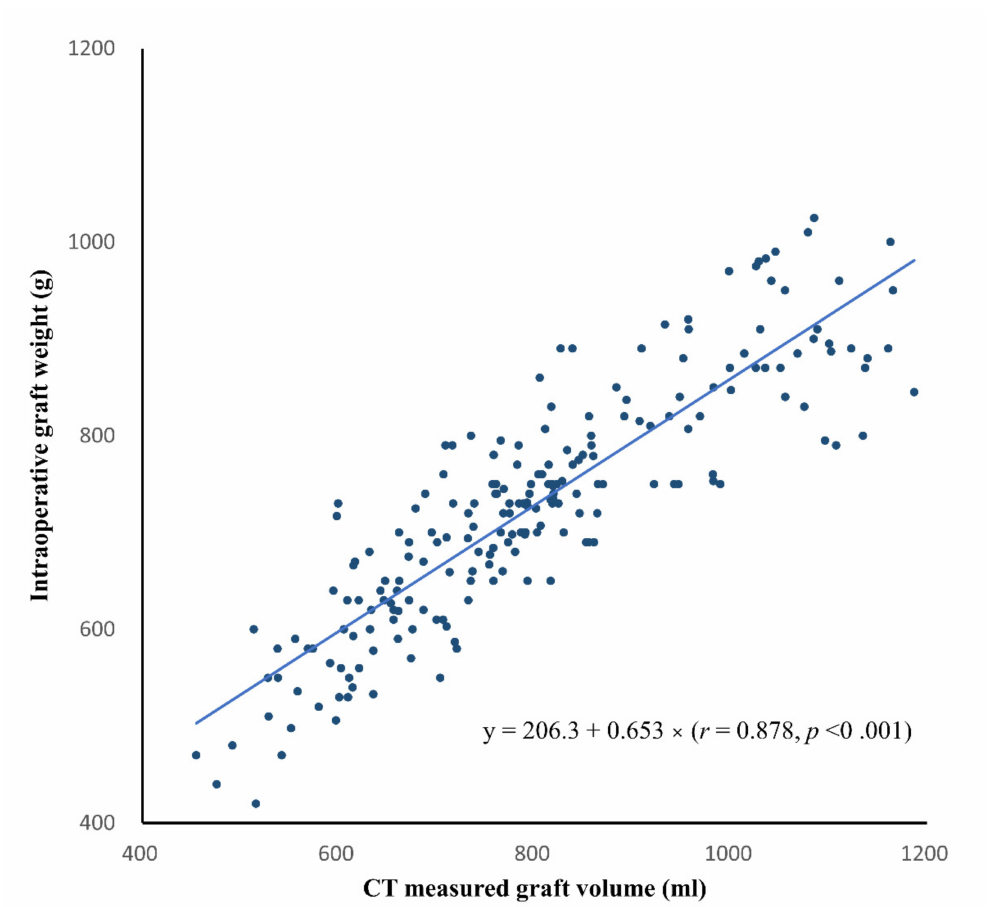
Figure 3. Scatter plot of the CT-measured graft volume versus intraoperative graft weight in the development group. The solid line indicates the best-fit regression line. The linear regression equation is also